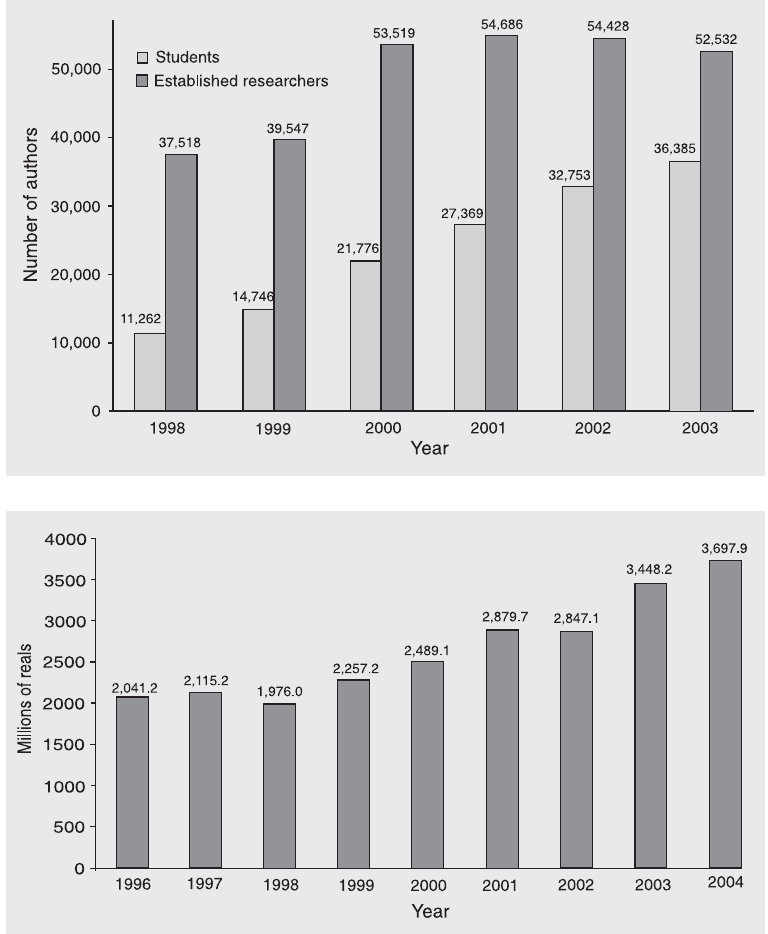
Figure 1. Brazilian authorship of publications, including established investigators and students, between 1998 and 2003 (original data source: Ministry of Science and Technology, http://www.mct.gov.br/estat).